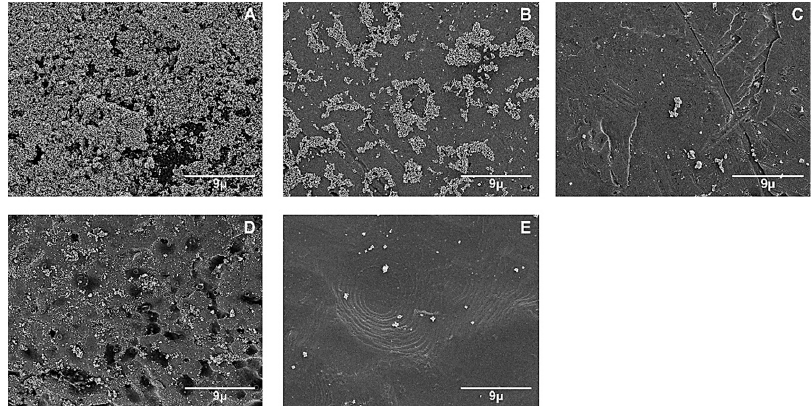
Figure 1. Representative micrographs from the SEM of orthodontic brackets with silver nanoparticles via the method proposed in [33] (2500× magnification): ( A ) GI, ( B ) GII, ( C ) GIII, ( D ) GIV, ( E ) GV. For bracket names, please refer to Section 2.1.